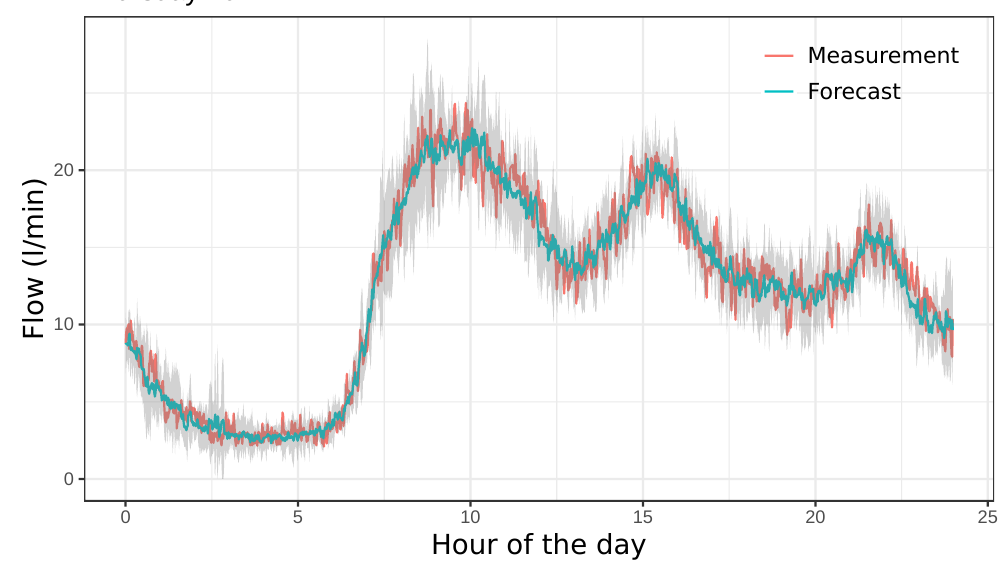
Figure 8. Example of a good forecast for the downtown site. The grey band represents the 10% pointwise confidence